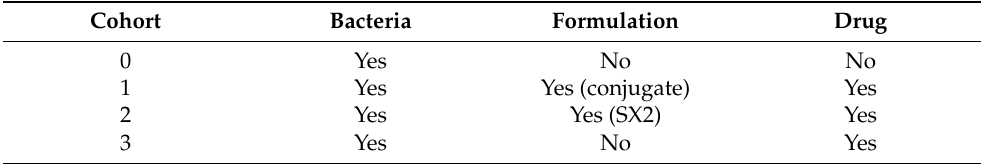
Table 1. Cohort chart of animal